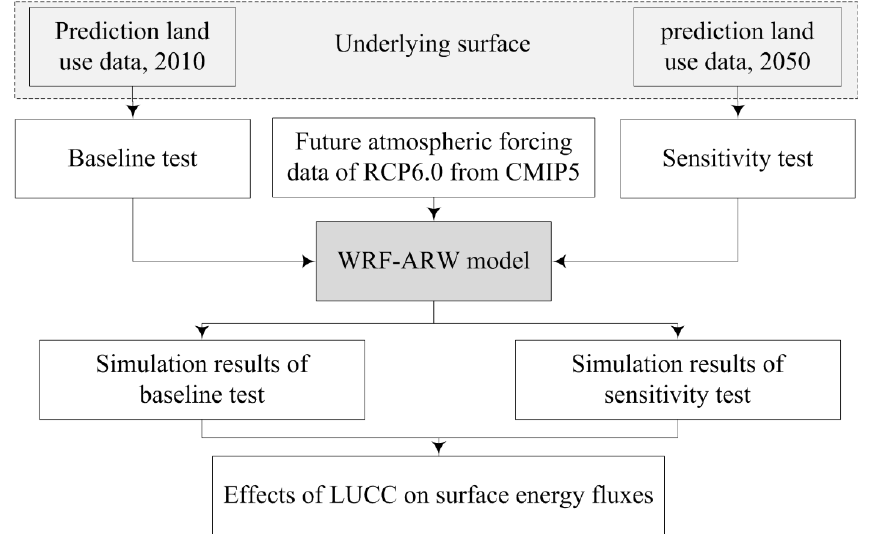
Figure 3. General procedure followed in the